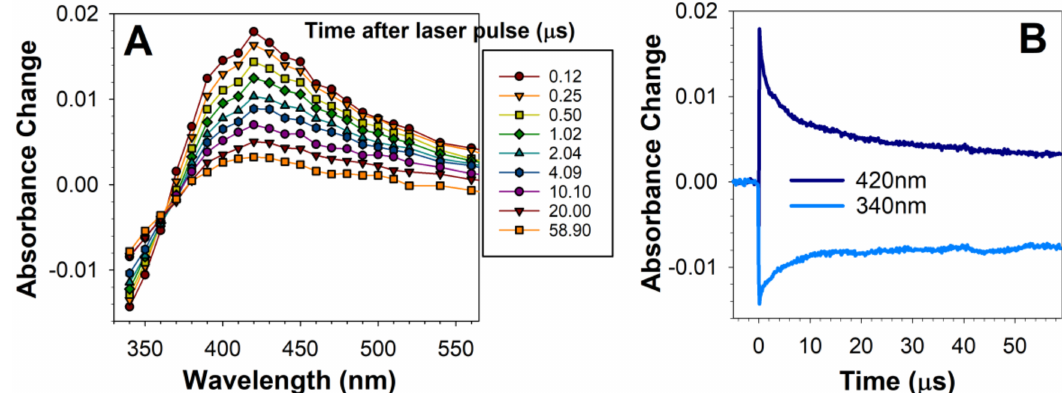
Figure 2. Photoexcitation of oxidised DHE with a 5 ns laser pulse results in the formation of a transient species with an absorption maximum at 420 nm. Representative absorption spectra of transient species generated at indicated times after photoexcitation of oxidised DHE ( A ) and kinetics of transient species formation and decay recorded at 420 nm, and sample bleaching and recovery monitored at 340 nm ( B ). Oxidised DHE was solubilised in argon-saturated acetone and exposed, at time 0, to a 5 ns laser pulse at 355 nm wavelength. The transient species exhibits an absorption maximum at about 420 nm and decays concomitantly with the partial recovery of absorption at 340